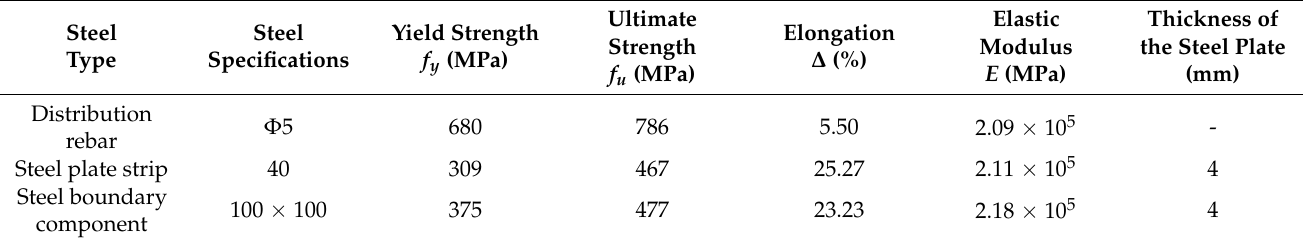
Table 2. Mechanical parameters of the concrete wall.